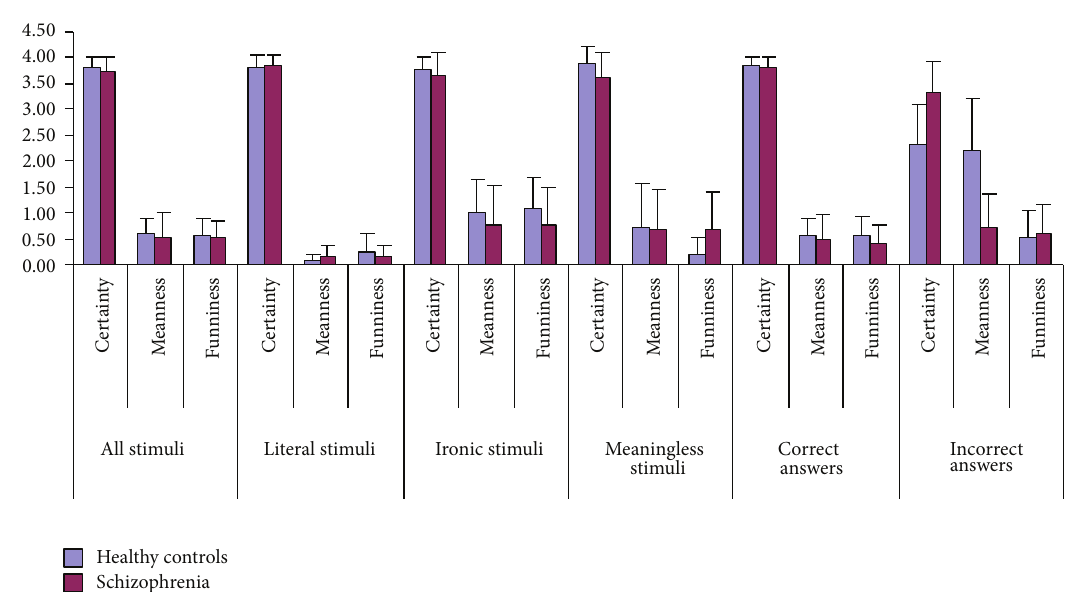
Figure 2: Detection and appreciation of irony. Group differences.